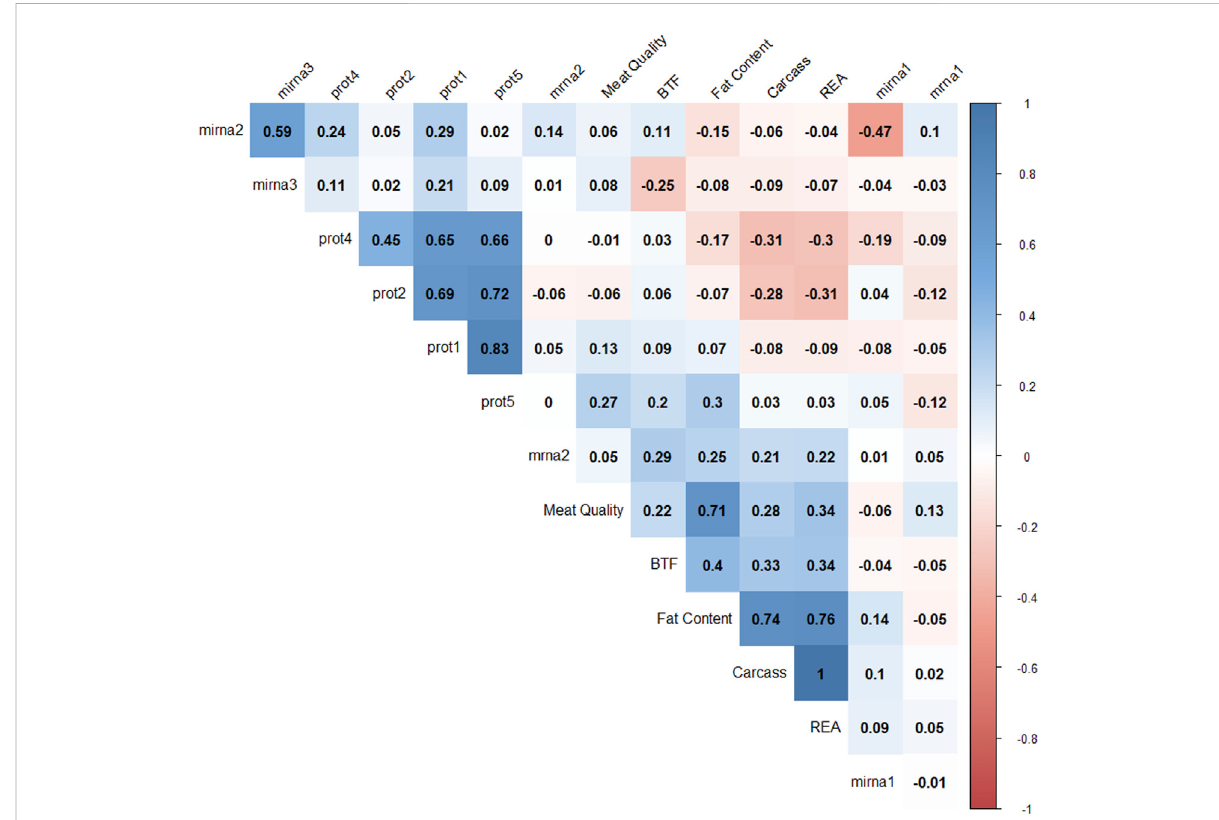
Correlation plot of 14 factor scores. The degree of shading and the value reported correspond to the correlation between each pair of latent